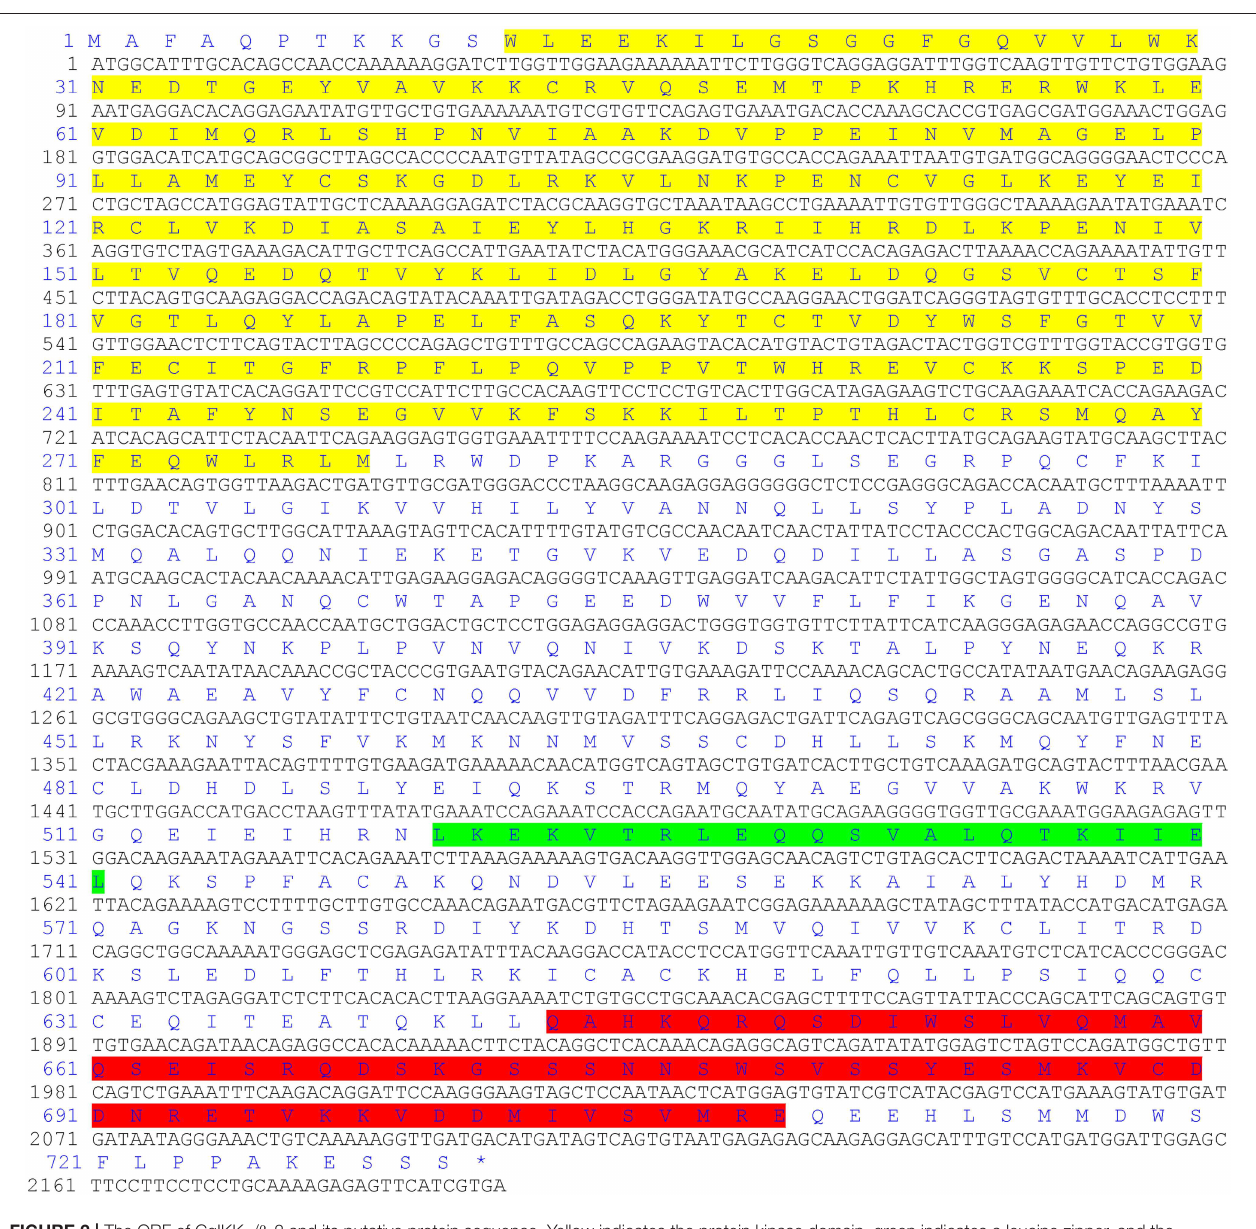
FIGURE 2 | The ORF of CgIKK α / β -2 and its putative protein sequence. Yellow indicates the protein kinase domain, green indicates a leucine zipper, and the C-terminal helix-loop-helical domain is shown in red.